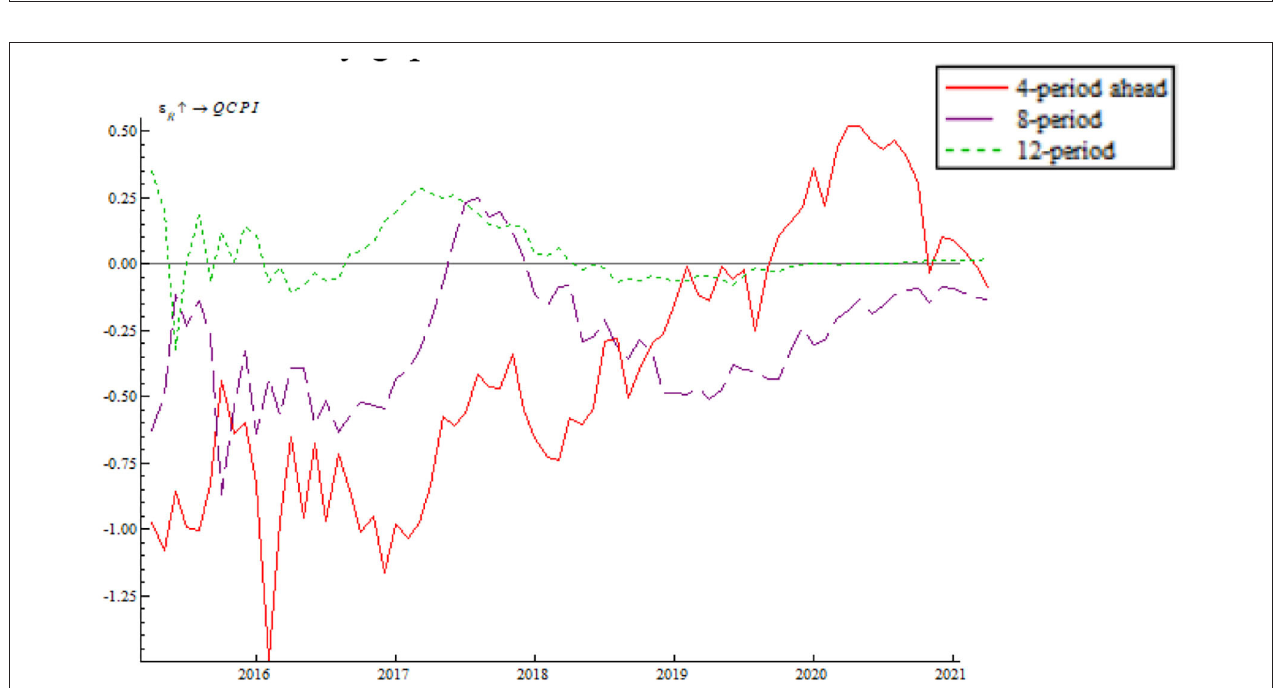
FIGURE 11 | Shock of the price-based monetary policy instrument on inflationary gap.